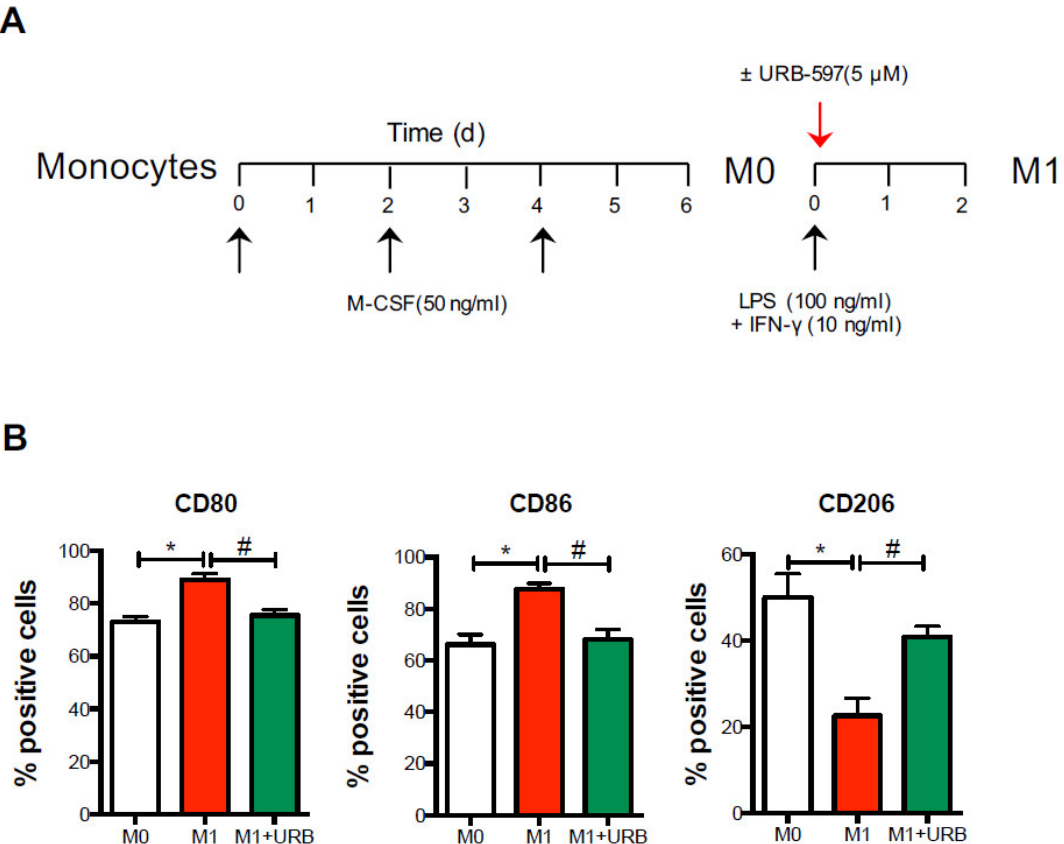
Figure 5. Pharmacological FAAH inhibition shifts M1 polarization. Cells from AD patients were differentiated into macrophages (M0) for 6 days in the presence of M-CSF, and subsequently polarized in M1 macrophages upon incubation with LPS and IFN-γ, in the absence or presence of the FAAH inhibitor URB-597 (URB) for 48 h. ( A ) By means of polychromatic flow cytometry, the surface expression of the polarization markers CD80, CD86 and CD206 was measured ( B ) as detailed in the materials and methods. Data are shown as mean ± s.e.m. of 4–5 independent experiments. * p < 0.05 vs. M0; # p < 0.05 vs. M1.